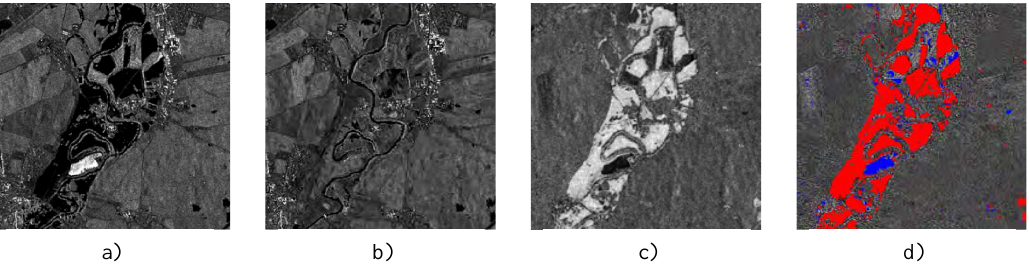
Figure 3 : Study area of Halle, Germany. Subsets of TerraSAR-X amplitude data (© DLR 2013) of a) 17/01/2011 and b) 08/02/2011, c) intensity ratio image between b) and a), d) classification based on the hypothesis test and the graph-cut algorithm, positive- and negative-change are shown in red and blue colors, no-change is